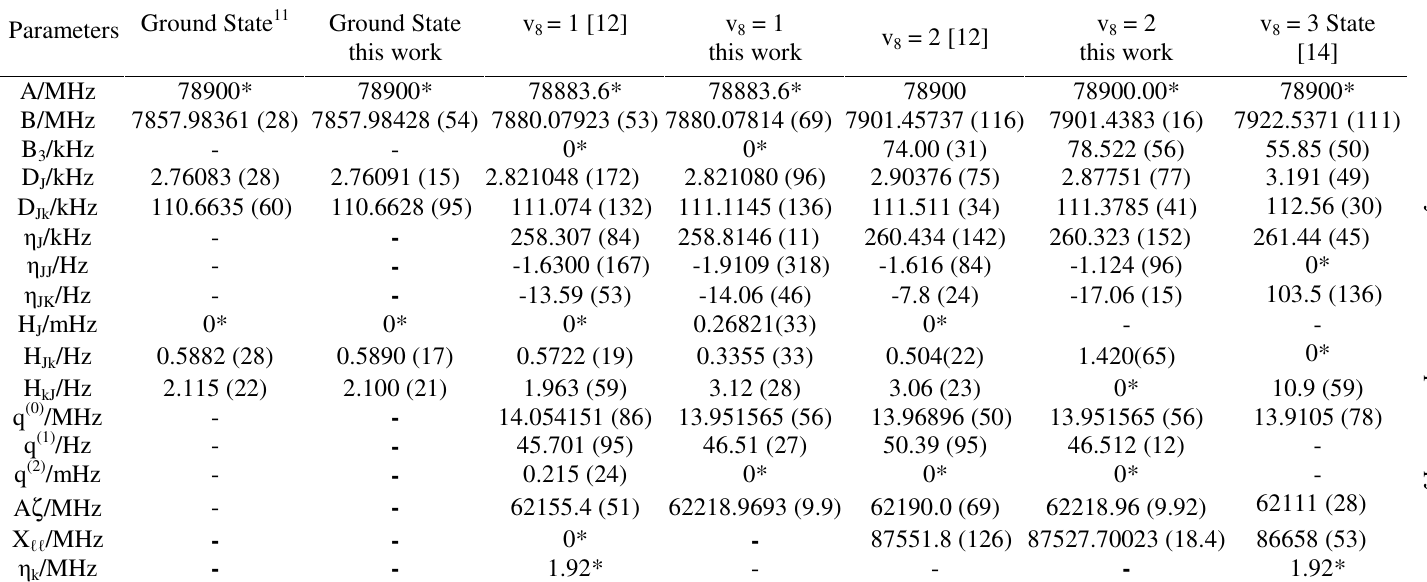
CN in Ground,v 3